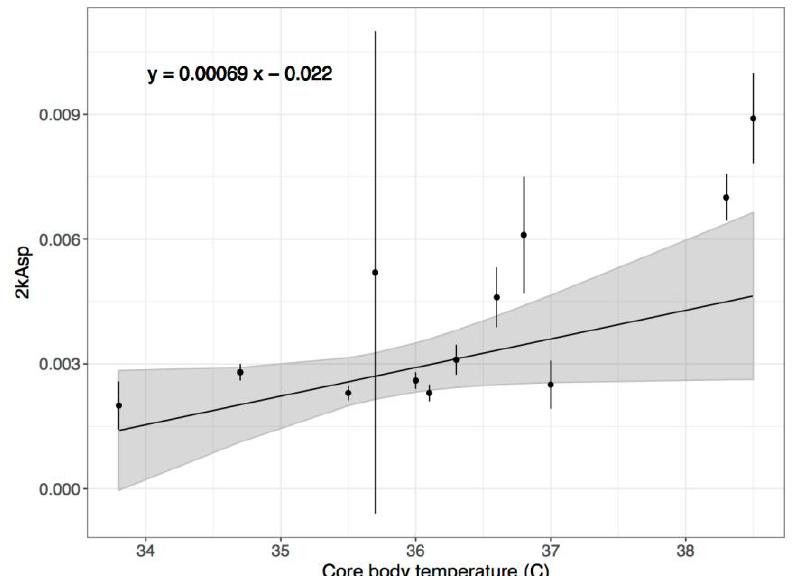
Fig. 3. The 2 k values estimated in this study for the pygmy goat, red- Asp necked wallaby, lion and hooded seal, and eight published 2 k for harp seal, narwhal, harbour porpoise, fin whale, bowhead whale, beluga whale, minke whale and human regressed (weighted regression) against average core body temperatures (°C) for each of the 12 species. The specific values are listed in Table 2. Error bars equal ±